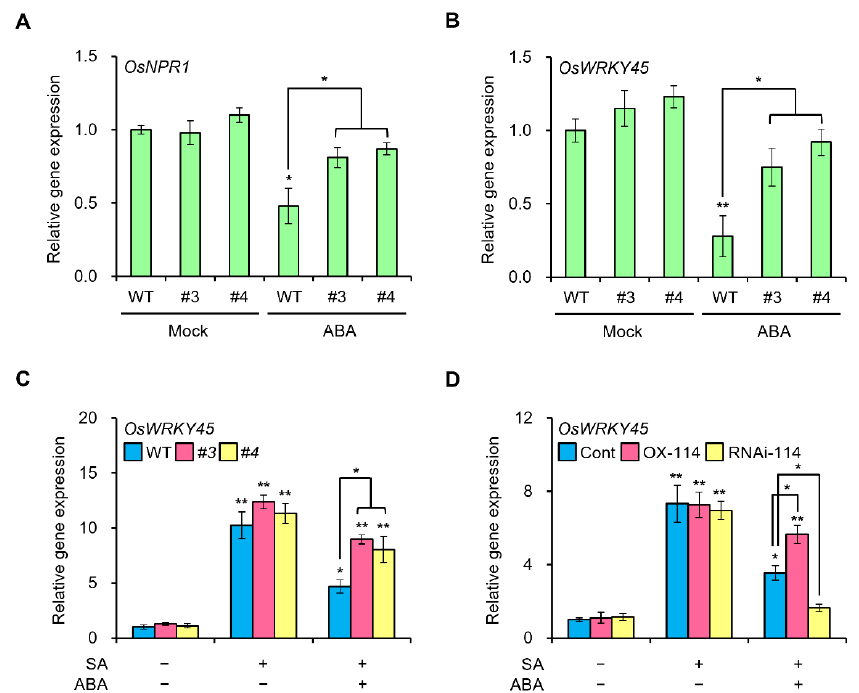
Figure 4. ABA-induced SA signaling suppression is alleviated by OsWRKY114. ( A , B ) Relative transcript levels for OsNPR1 ( A ) and OsWRKY45 ( B ). Four-week-old rice plants were pretreated with 100 µ M ABA or mock solution. Three days later, leaves were inoculated with Xanthomonas oryzae pv. oryzae . Samples were collected 4 days later for RT-qPCR analysis. OsActin was used as an internal control. Data are shown as means ± SD. * p < 0.05, ** p < 0.01, determined by t -test relative to mock-treated wild-type sample and between the indicated comparing samples. ( C ) Gene expression OsWRKY45 in SA- or SA+ABA-treated OsWRKY114 OX and wild-type plants. A total of 500 µ M SA was applied to leaf segments of OsWRKY114 OX and wild-type plants alone or with 50 µ M ABA. After 8 h of incubation, total RNA was isolated for RT-qPCR analysis. OsActin was used as an internal control. Data are shown as means ± SD. * p < 0.05, ** p < 0.01, determined by t -test relative to non-treated wild-type sample and between the indicated comparing samples. ( D ) Gene expression of OsWRKY45 in SA- or SA+ABA-treated protoplasts. Rice protoplasts were transfected with or without constructs pEarleyGate104/ OsWRKY114 and pB7GWIWG(II)/ OsWRKY114- RNAi, respectively, and then 500 µM SA was treated to protoplasts alone or with 50 µM ABA. After 8 h of incubation, total RNA was isolated for RT-qPCR analysis. OsActin was used as an internal control. Data are shown as means ± SD. * p < 0.05, ** p < 0.01, determined by t -test relative to non-treated control sample and between the indicated comparing samples.